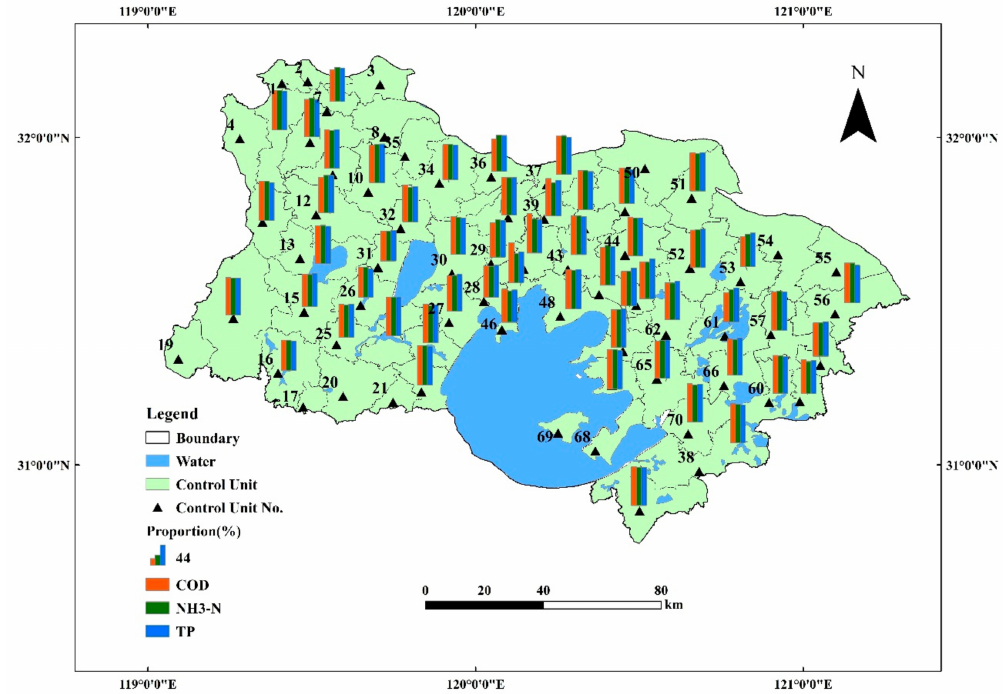
Figure 3. Control unit division results and weight of control unit internal pollution against control section water